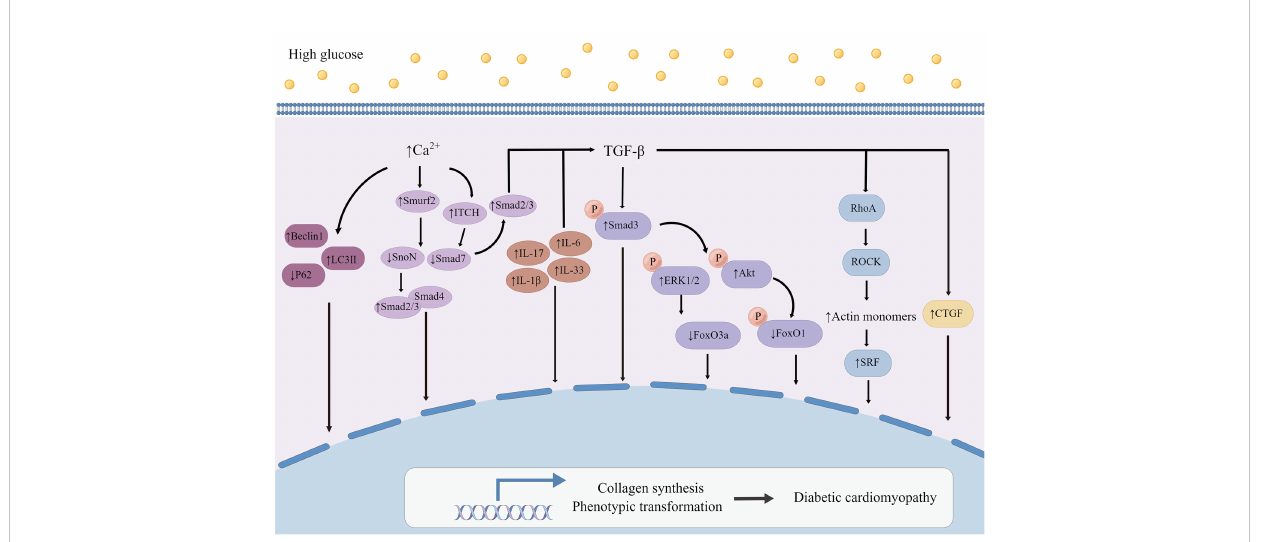
FIGURE 4 Mechanism of myocardial fi broblasts on myocardial fi brosis in diabetic cardiomyopathy. High glucose increases the expression and activity of TGF- b and causes a series of changes in signal pathways regulating the phenotypic transformation and synthesis function of CFs. The expressions of Interleukin (IL), including IL-6, IL-17, IL-1 b and IL-33, were all up-regulated in myocardial fi broblasts attacked by HG, especially, IL-6 seems to up- regulate collagen gene by inducing transforming growth factor-beta 1 (TGF- b ). At the same time, increased Ca 2+ concentration regulated by CaSR could modulate the ubiquitination of Smad7 to affect DCM. By Figdraw. Smurf2, Smad speci fi c E3 ubiquitin protein ligase 2; SnoN, SKI like proto- oncogene; Smad2/3, Smad family member 2 and Smad family member 3; Smad4, Smad family member 4; Smad7, Smad family member 7; ITCH, itchy E3 ubiquitin protein ligase; p-ERK1/2, phosphorylation of extracellular signal-regulated kinase 1/2; p-Smad3, phosphorylation of smad family member 3; p-AKT, phosphorylation of protein kinase B; p-FoxO1, phosphorylation of forkhead box O1; RhoA, ras homolog family member A; ROCK, Rho-associated coiled-coil containing kinases; SRF, serum response factor; CTGF, connective tissue growth